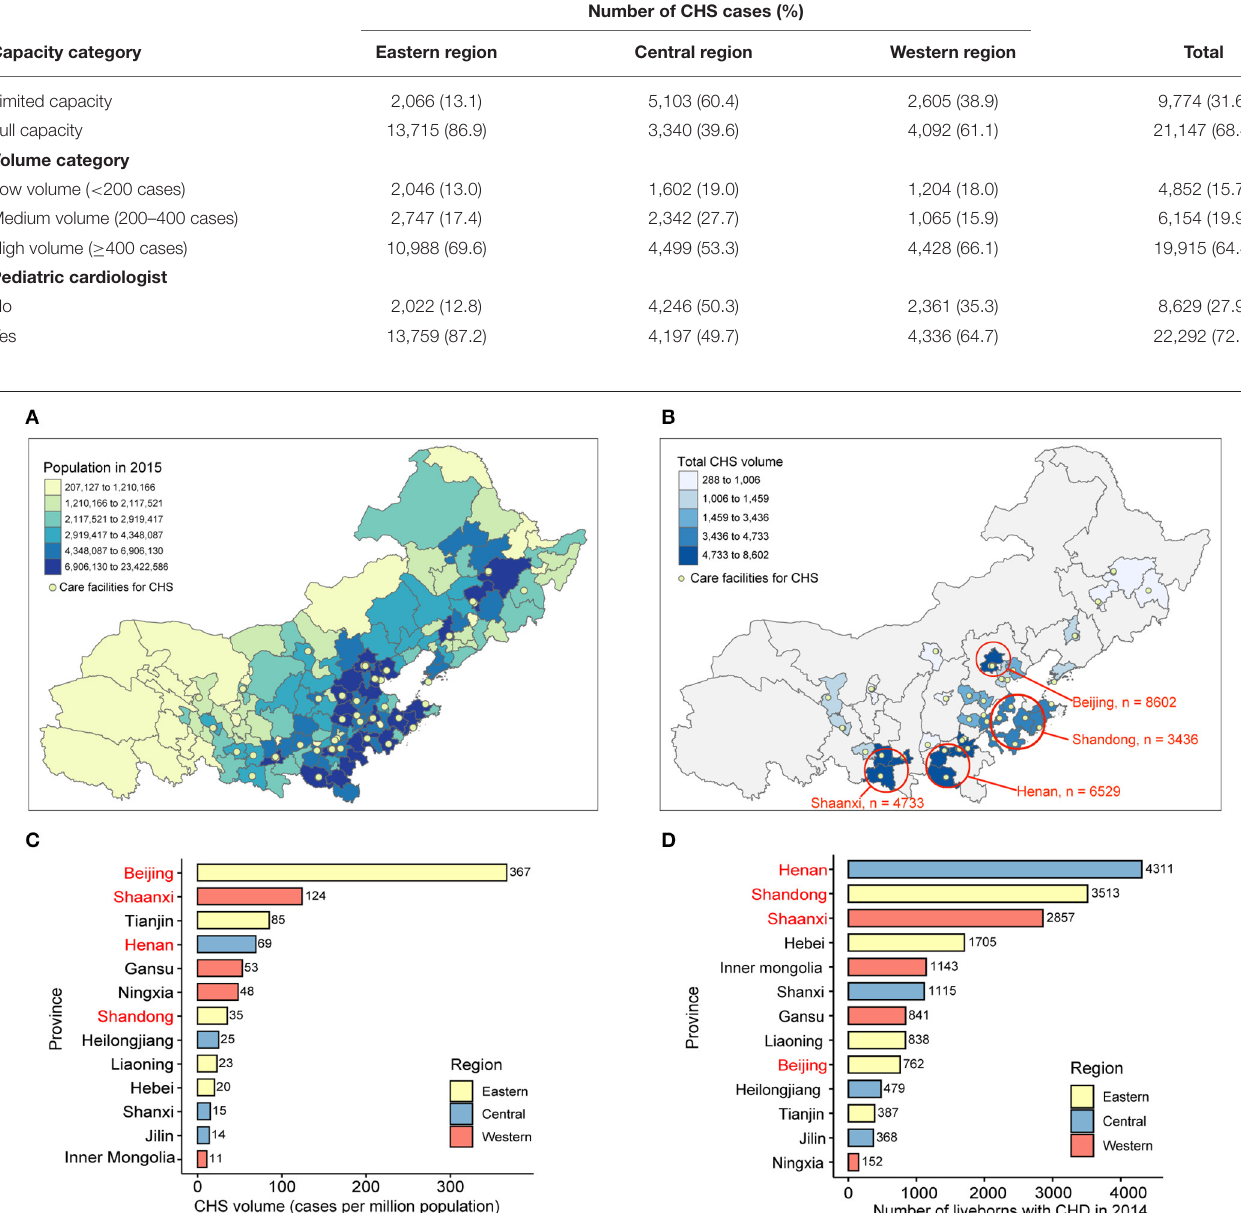
TABLE 3 | Congenital heart surgery volume stratified by facility characteristics and economical regions.